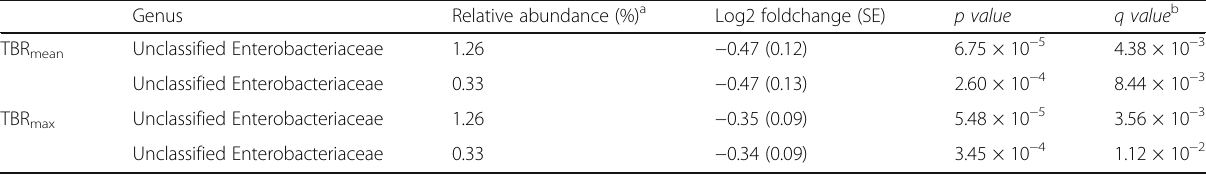
Table 3 Association gut microbiota and TBR max and TBR mean at the level of genus Genus